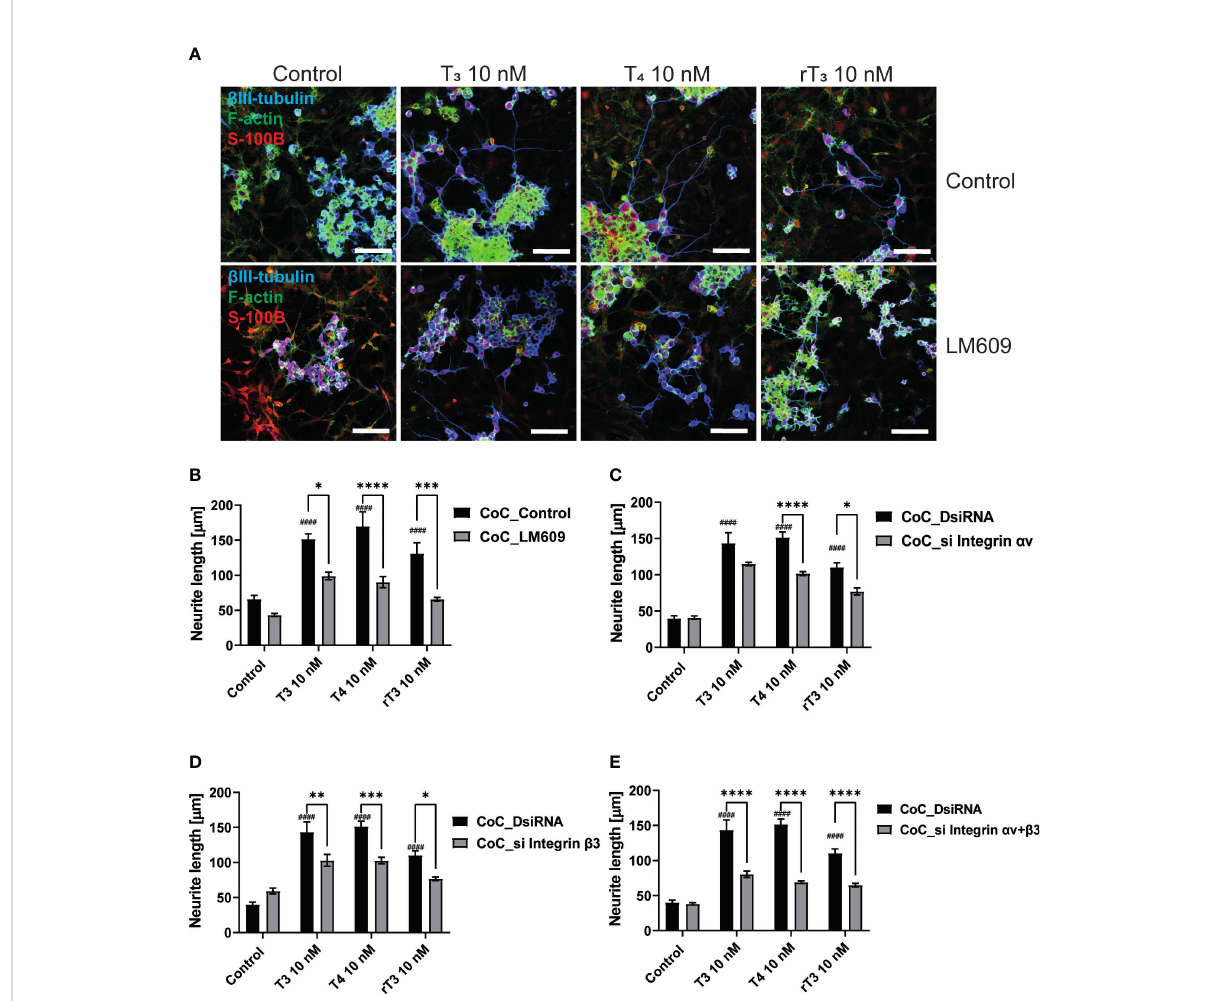
FIGURE 6 Integrin a v b 3 affect neurite outgrowth induced by TH in co-culture of astrocytes and Neuro-2A cells. (A) Representative photomicrographs showing the effects of TH and co-exposure with LM609 in the co-culture of astrocytes and Neuro-2A cells, on the differentiation of Neuro-2A cells. Neuro-2A cell differentiation was induced by serum starvation for one to three days, followed by immunostaining with b -tubulin III (blue), F-actin (green), and S100B (astrocytes marker) (red). Quantitative analysis of the effect of TH after exposure to LM609 (B) , integrin av siRNA (C) , integrin b3 siRNA (D) , and integrin av and b3 siRNA (E) , on neurite length in Neuro-2A cells. Neurite length was quanti fi ed using ImageJ Fiji software (NIH). Bars indicate 50 m m. **** p < 0.0001, *** p < 0.001 and ** p < 0.01 * p < 0.05, indicates statistical signi fi cance according to two- way ANOVA continued with post hoc Turkey test compared to control. #### p <0.0001, indicate statistical signi fi cance according to two-way ANOVA continued with post hoc Turkey test. See Supplementary Table